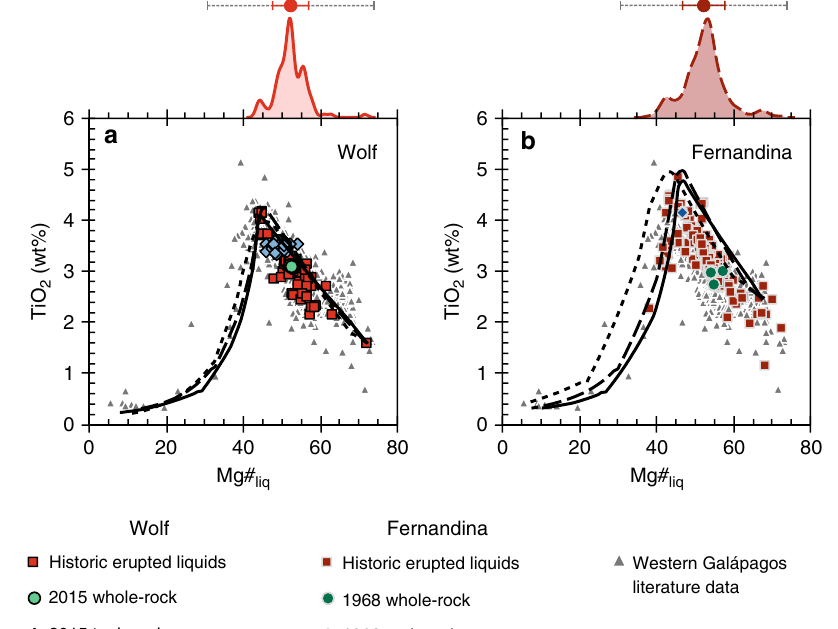
Fig. 2 Erupted liquid compositions from the Galápagos Archipelago. TiO 2 vs. Mg# liq of erupted liquids at a Wolf volcano and b Fernandina. The points show: whole-rock, tephra glass, submarine glass and melt inclusion literature data from all volcanoes in the western Galápagos Archipelago (excluding intrusive rocks and plagioclase-ultraphyric lavas); historic erupted liquids (i.e. whole-rocks, tephra glasses and submarine glasses) from Wolf and Fernandina; and whole-rock and tephra glass data from the 2015 Wolf and 1968 Fernandina eruptions (see legend). References for Wolf and Fernandina historic erupted liquids and literature data from all western Galápagos volcanoes are in Supplementary Note 2. Glass data for the 2015 Wolf eruption are from Stock et al. 19 and whole-rock data are from this study. Glass and whole-rock data for the 1968 Fernandina eruption are from Allan and Simkin 28 . Characteristic 2 σ analytical uncertainties for our whole-rock analyses are less than the size of a data point. The black lines show liquid lines of descent calculated using Rhyolite-MELTS at 50 MPa (solid line), 300 MPa (dashed line) and 500 MPa (dotted line). The kernel density estimates above each panel show the Mg# liq distribution of the historic erupted liquids from Wolf and Fernandina, the red points show their median Mg# liq , and the red bars show their Mg# liq interquartile range. The grey dotted bars above each panel show the Mg# liq interquartile range of historic lavas from Santiago 26 (centred around the Wolf and Fernandina medians) for